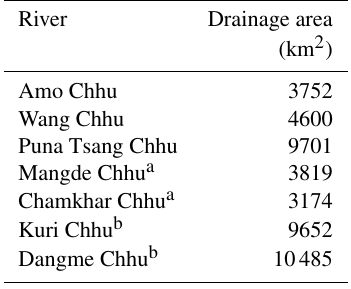
Table 1. Drainage areas of large Himalayan rivers in Bhutan, taken upstream of their outlet at the mountain front or upstream of a major confluence.